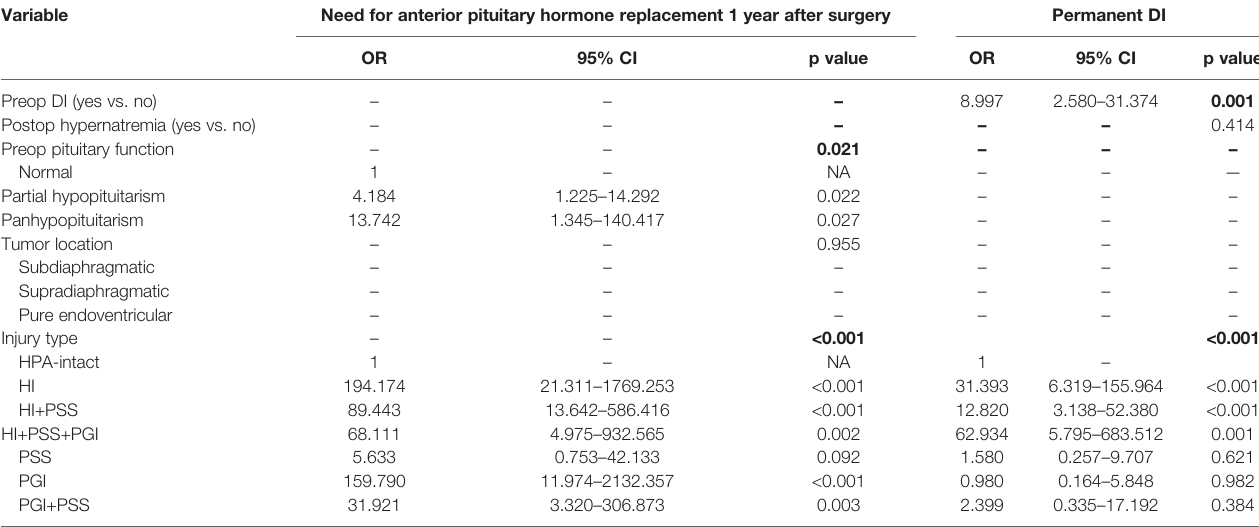
TABLE 3 | Multivariate logistic regression analysis of need for anterior pituitary hormone replacement 1 year after surgery and permanent diabetes insipidus (DI) in the training cohort. Variable